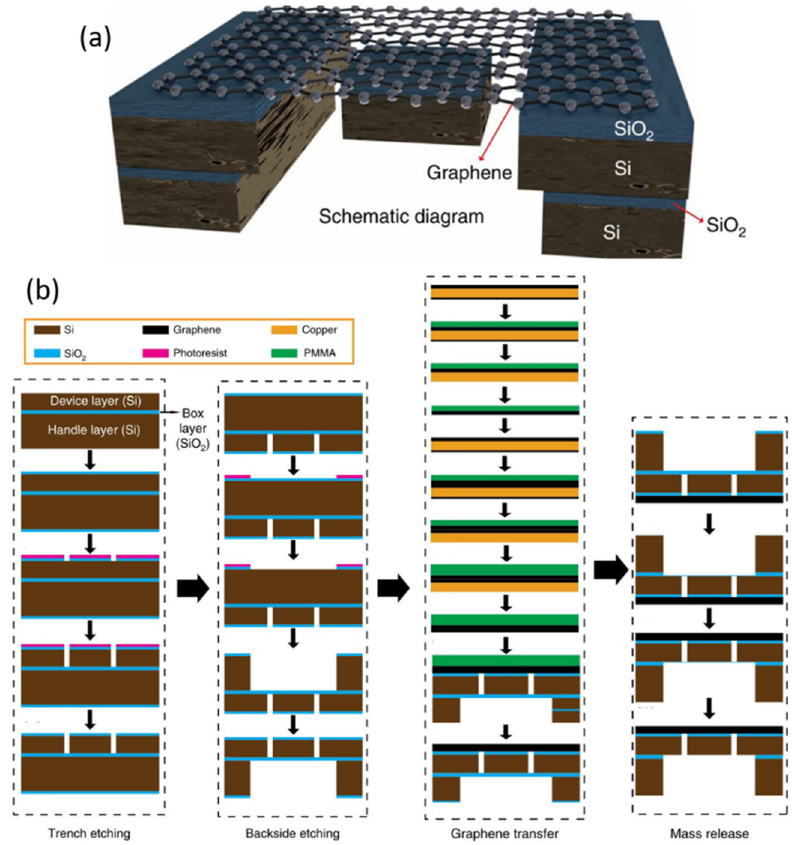
Figure 2. Graphene membranes with suspended silicon proof masses [30]. ( a ) The structure of de- vice. ( b ) The fabrication process of device. ( b ) The fabrication process of